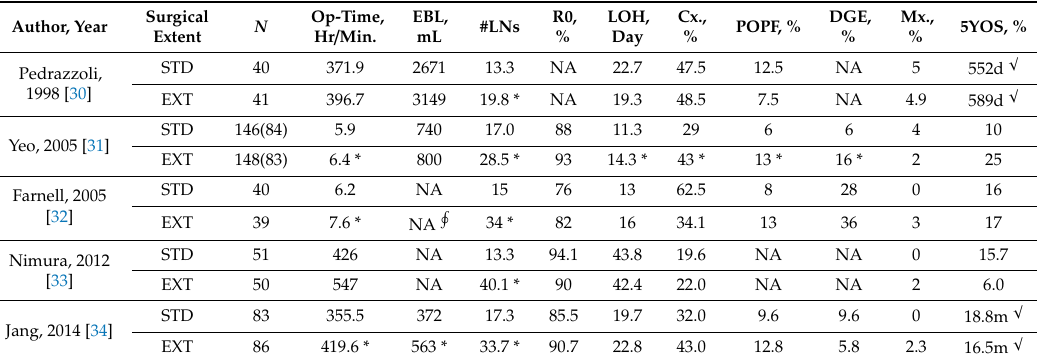
Table 2. Literature review of randomized control trials (RCTs) comparing standard PD and extended PD in treating pancreatic